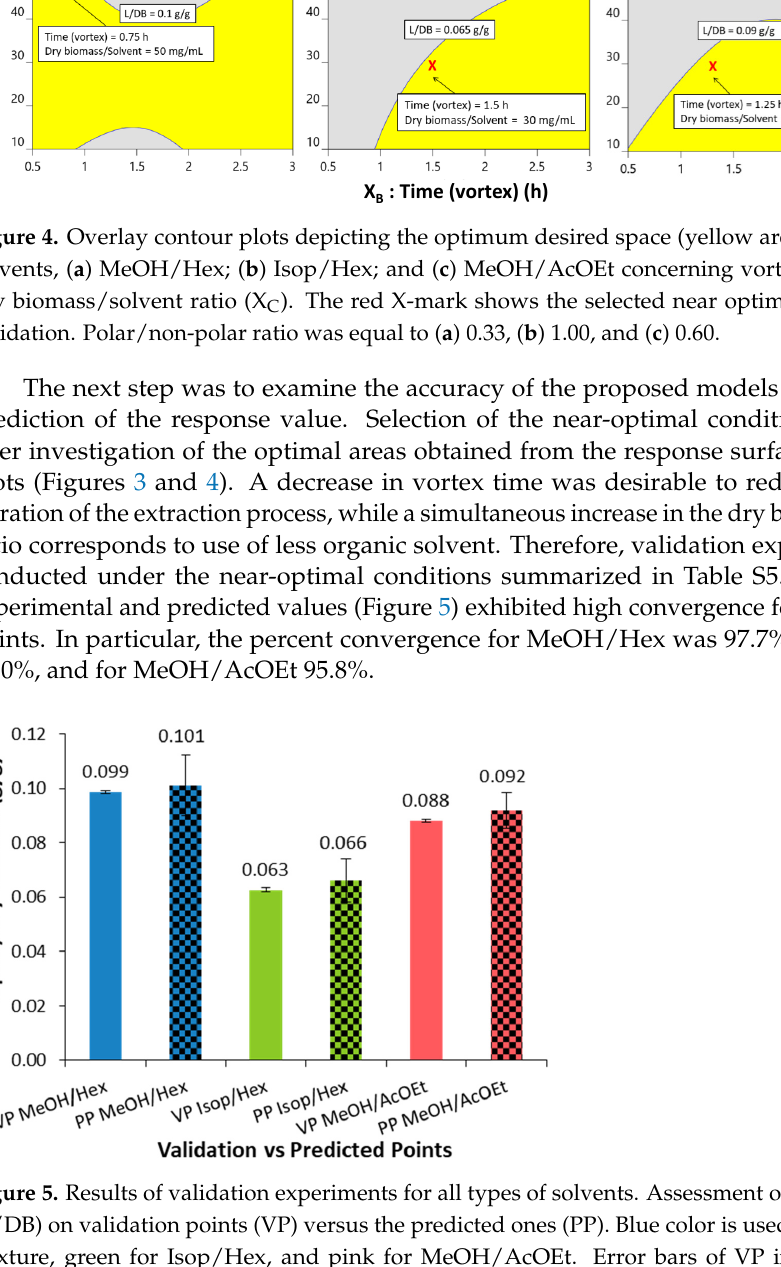
Figure 5. Results of validation experiments for all types of solvents. Assessment of response values (L/DB) on validation points (VP) versus the predicted ones (PP). Blue color is used for MeOH/Hex mixture, green for Isop/Hex, and pink for MeOH/AcOEt. Error bars of VP indicate standard deviation of three replicates, whereas error bars of PP designate the estimated standard deviation of the model.